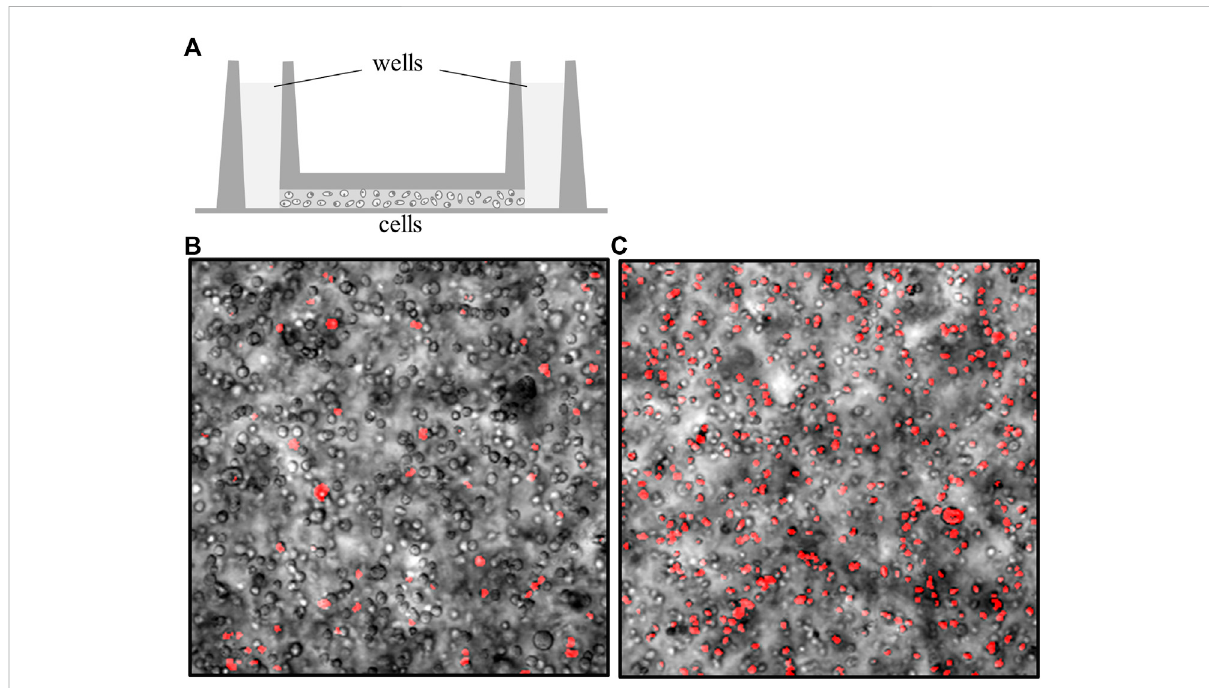
FIGURE 4 Cell mortality increases in the absence of interstitial fl ow. (A) Cells were mixed in arti fi cial matrices and loaded into IBIDI channel slides (side view).Awellon eachsideis fi lled withculturemediathatiscontinuous with fl uid- fi lledadapters(notshown)(SarkarandMesserli,2021).Thechannel that spans between both wells is fi lled with a high density of cells embedded in different matrices. (B) Overlay of cells (transmitted light) with cells stainedwithpropidiumiodide(pseudo-coloredred)toidentifythenecroticcells.Thisimagewasacquiredimmediatelyafterloading,gellingthe matrix, and staining the cells in a 2% gelatin matrix, day 0. (C) Overlay of transmitted light cells with propidium iodide-stained cells after 48 h, in the absence of perfusion. Under these conditions, cell mortality increases by a factor just greater than 3, on average.